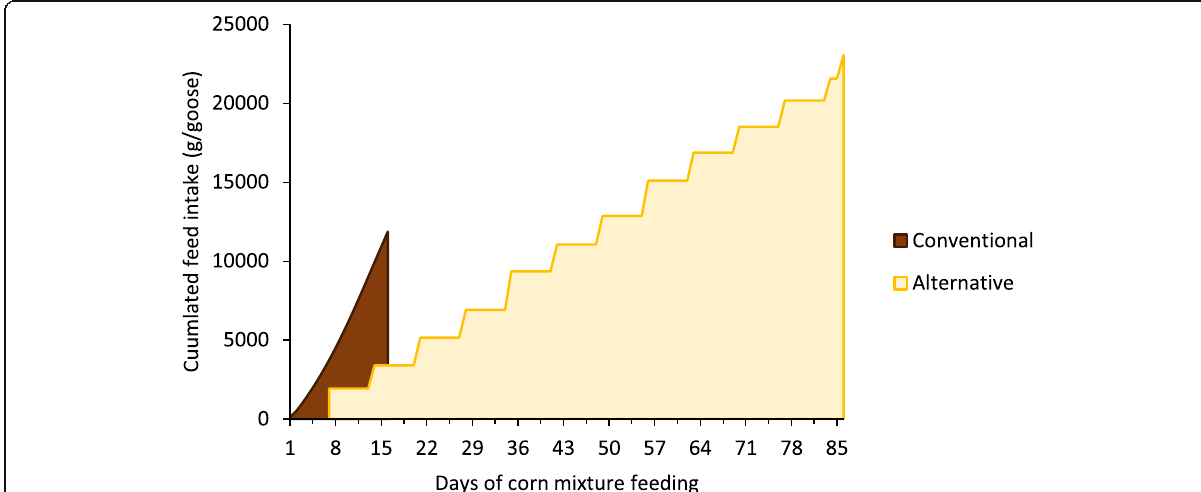
Fig. 2 Cumulated feed intake during the corn mixture feeding periods (CO during 16 days in the Conventional system and AF during 12 weeks in the alternative system). Feed intake is expressed in equivalent of dry matter. Intake was measured daily in the conventional system and weekly in the alternative system